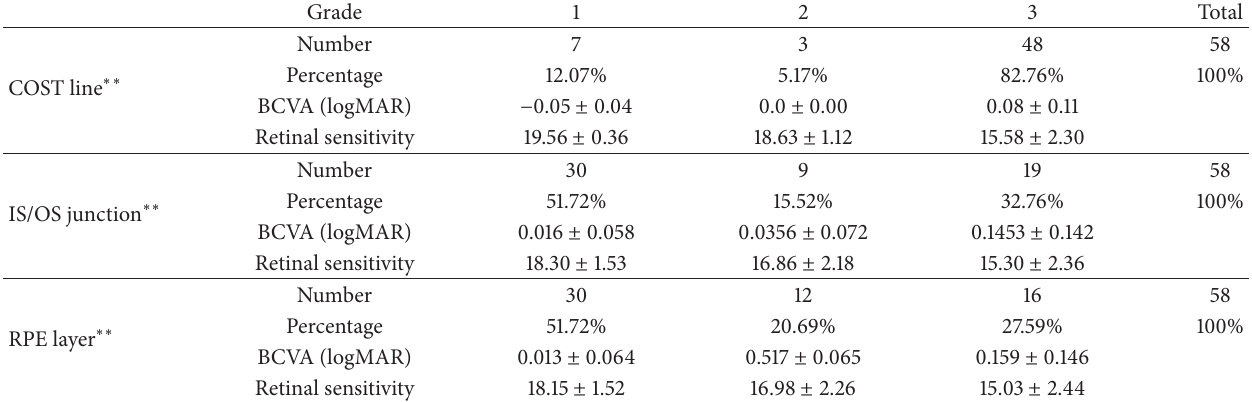
Table 2: Visual function of 58 late-stage (12 months after disease onset) VKH eyes with different OCT gradings.